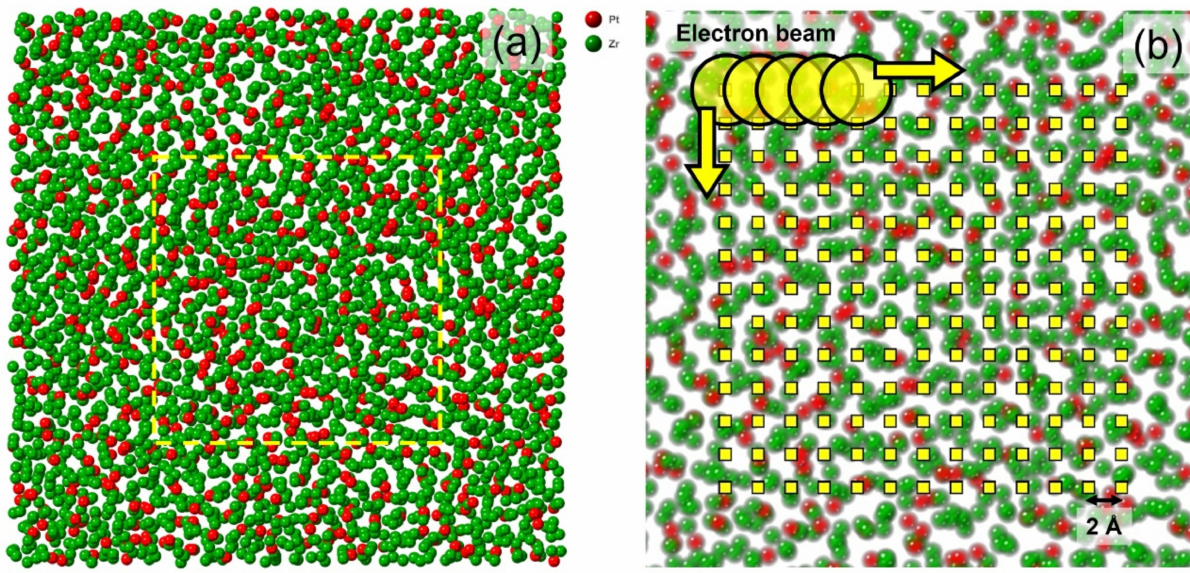
Figure 1. ( a ) Projection of an atomic configuration of the Zr 80 Pt 20 metallic glass sliced into a 2 nm thickness. ( b ) Positions where the electron beam is virtually irradiated on the atomic configuration surrounded by the dotted lines in ( a ). The interval between spots is 0.2